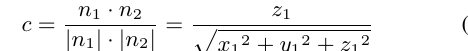
Figure 2. Illustration of two-level graphical model generation